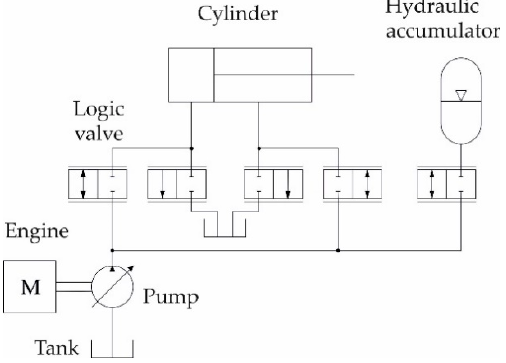
Figure 8. Hybrid without pump–motor with logic valves.